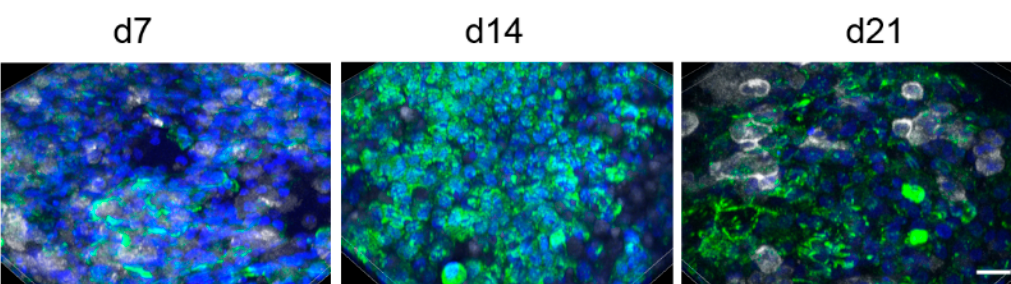
Figure 2. A549 were identified by anti-CK18 antibody (green) and THP-1 cells by anti-CD45 staining (white). Nuclei are counterstained with Hoechst 33342 (blue). Z-stack images of the A549/THP-1 co-cultures were reconstructed and shown as 3D projections. Scale bar: 20 µm.